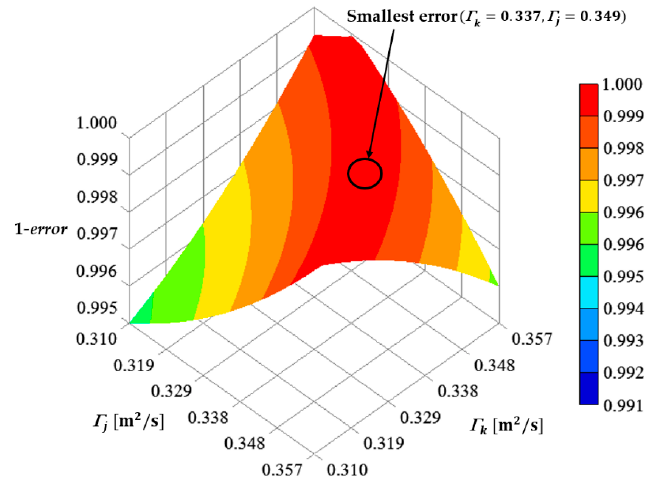
Figure 8. Three-dimensional chart showing the distribution of the value of 1 − error in the model calculation of two rotors in the CO-like layout with a narrow searching range from 0.95 Γ SI to 1.1 Γ SI